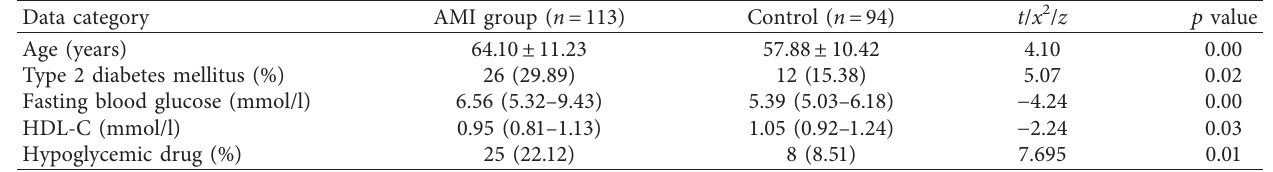
Table 3: Baseline data (which showed differences between the test and the control groups).